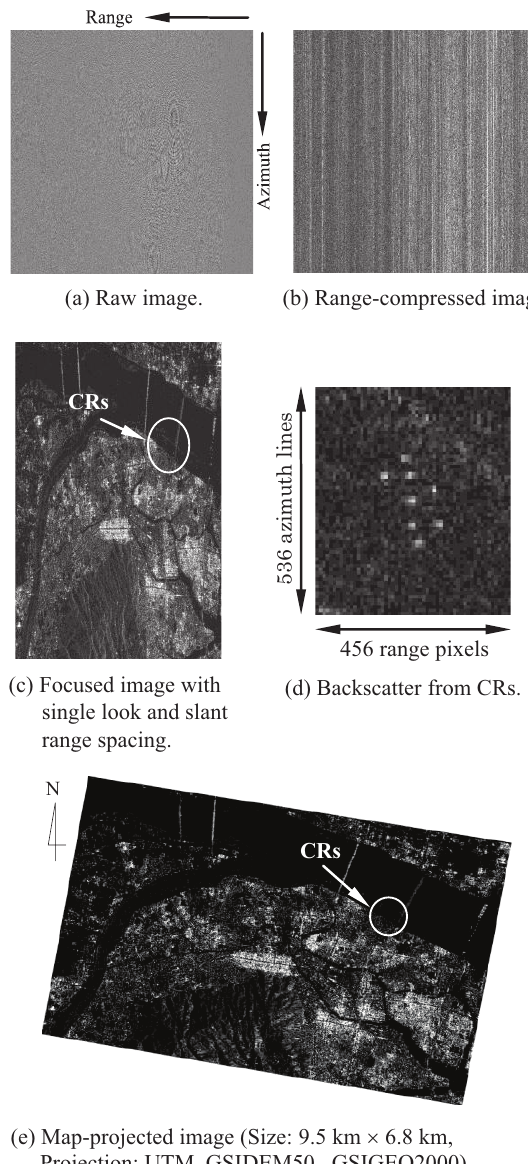
(e) Map-projected image (Size: 9.5 km (cid:6) 6.8 km, Projection: UTM, GSIDEM50, GSIGEO2000).